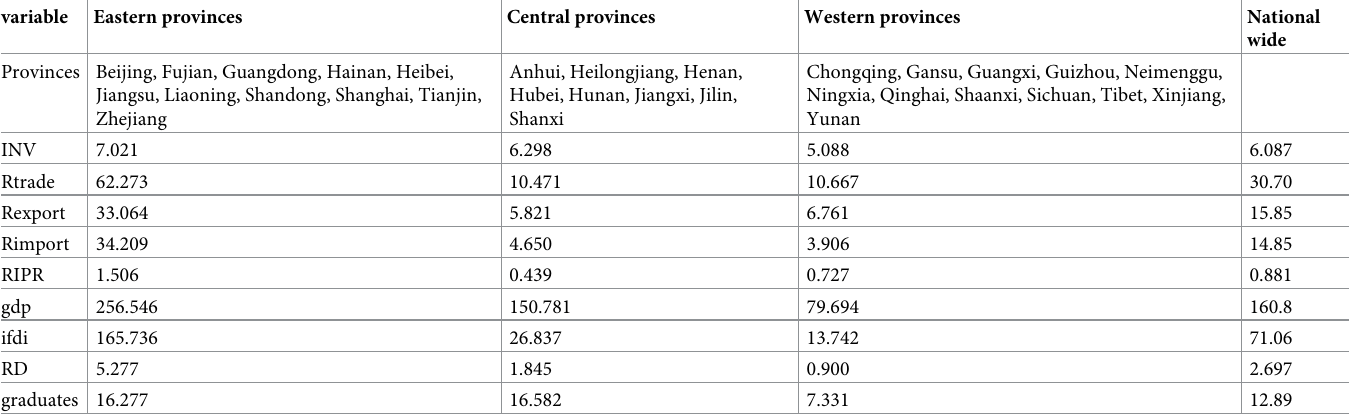
L . innovation represents the lagged one-period of the explained variable. With the inclusion of lagged explained variables, Eqs (3) and (4) become dynamic panel-data models and tradi- tional estimation methods like OLS would yield inconsistent and biased estimates because the lagged variable is often correlated to the error terms. The Generalized Method of Moments (GMM method) proposed by Wang et al., [45] has been useful in solving the above estimation error. GMM method can be divided into one-step estimation and two-step estimation accord- ing to different weight matrices. Radivojevi ć et al., [46] believe that the standard error of two- step GMM estimates has significant downward biases in the case of limited samples. Besides, Table 3. Mean values of key variables in different regions.